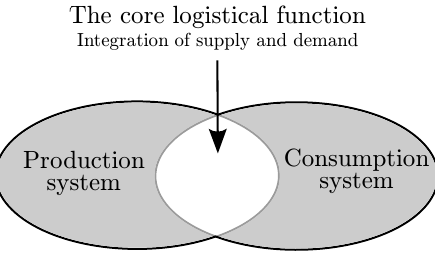
Figure 5: The core logistical function — integration of supply and demand (Ericsson